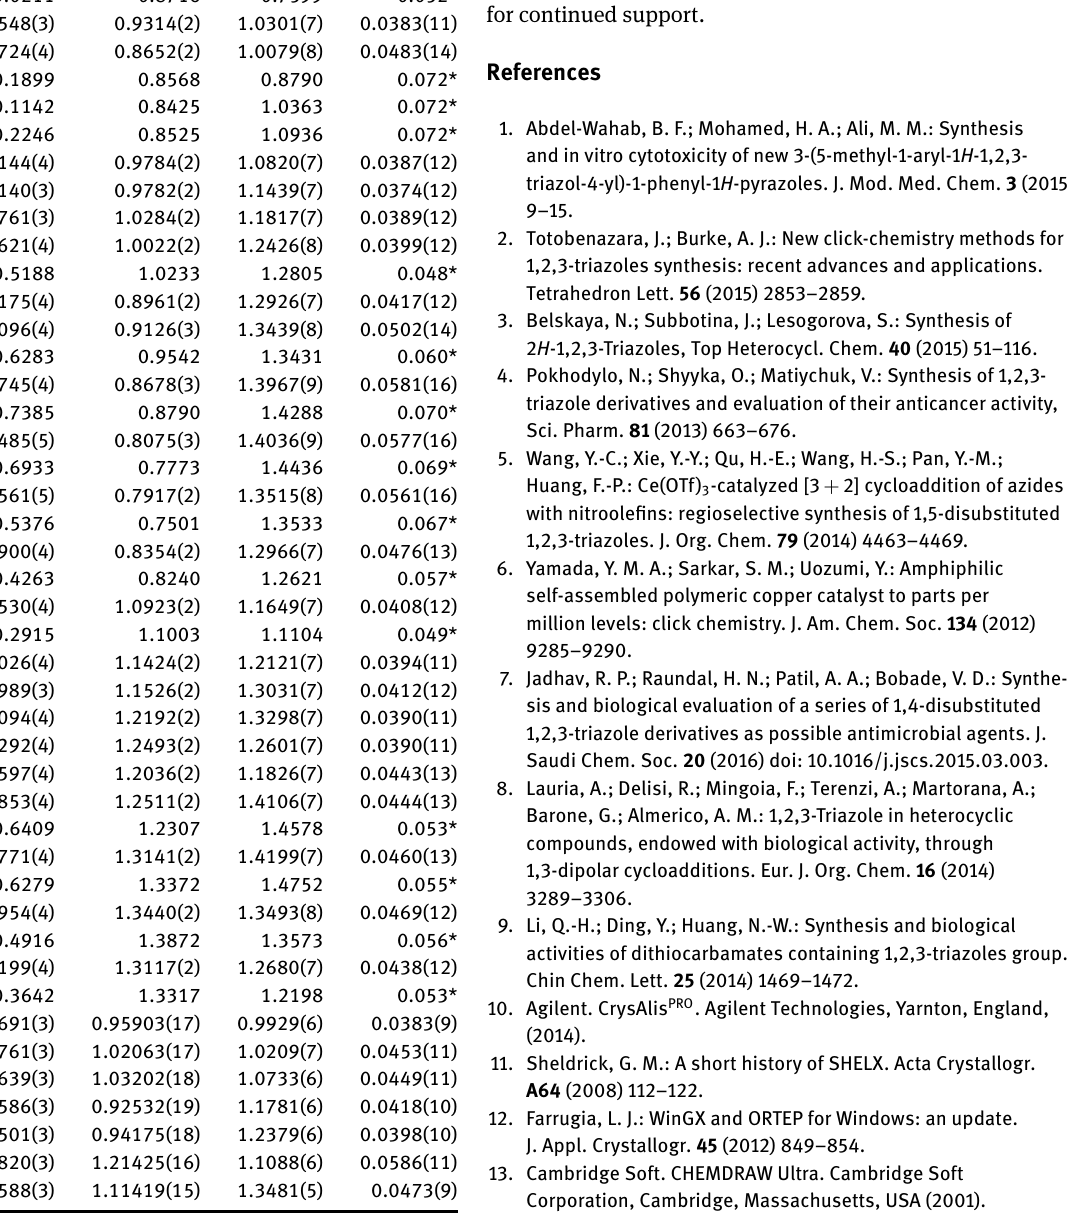
centroid distance = 3.86